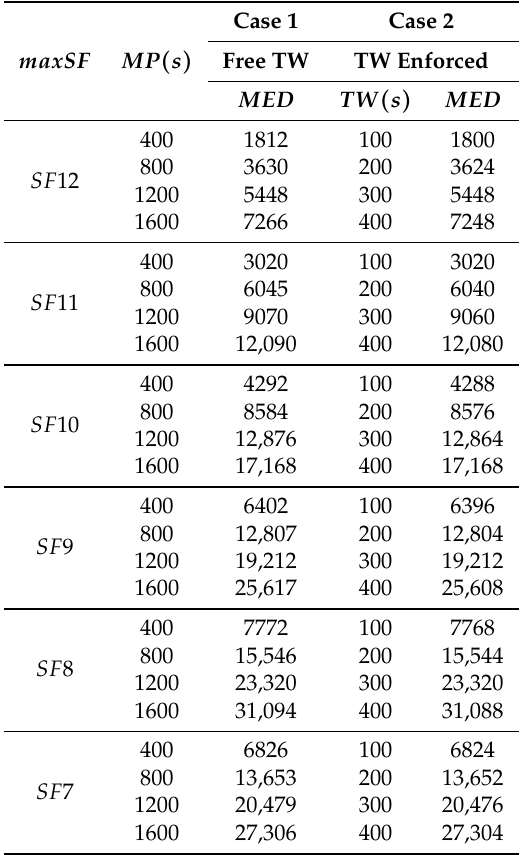
Table 6. Maximum number of EDs supported by